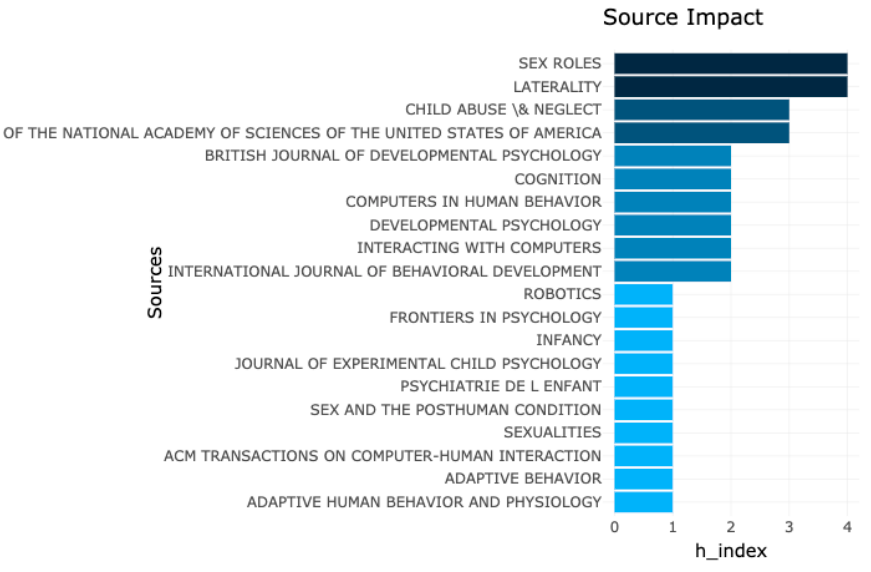
Figure 9. H-index of the sources used in the search.